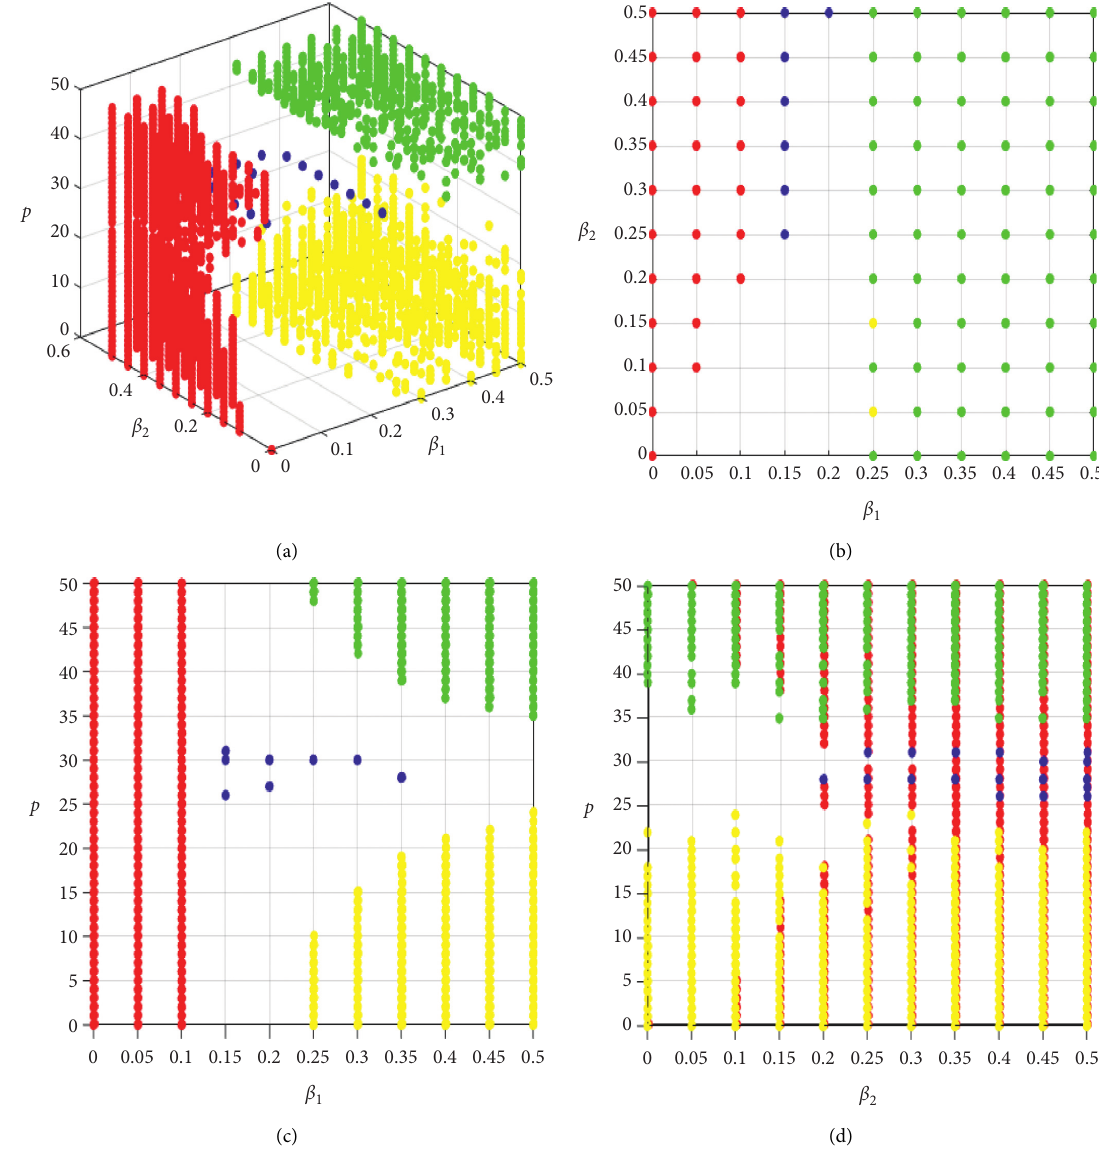
Figure 10: Pareto solutions at period four. (a) The stereogram of period four, (b) top view of the stereogram, (c) left view of the stereogram, and (d) right view of the